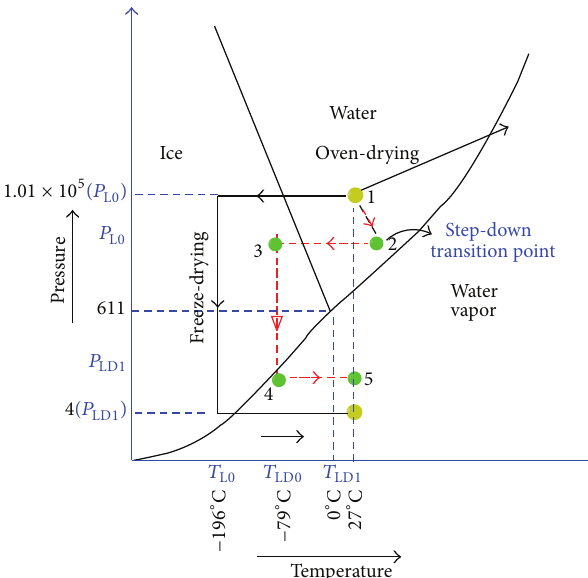
Figure 2: Phase diagram for cells under lyophilisation and desicca-